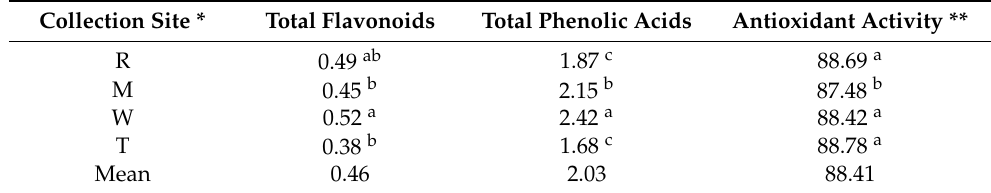
Table 3. Polyphenol content (%) and antioxidant activity (%) values of tansy inflorescences